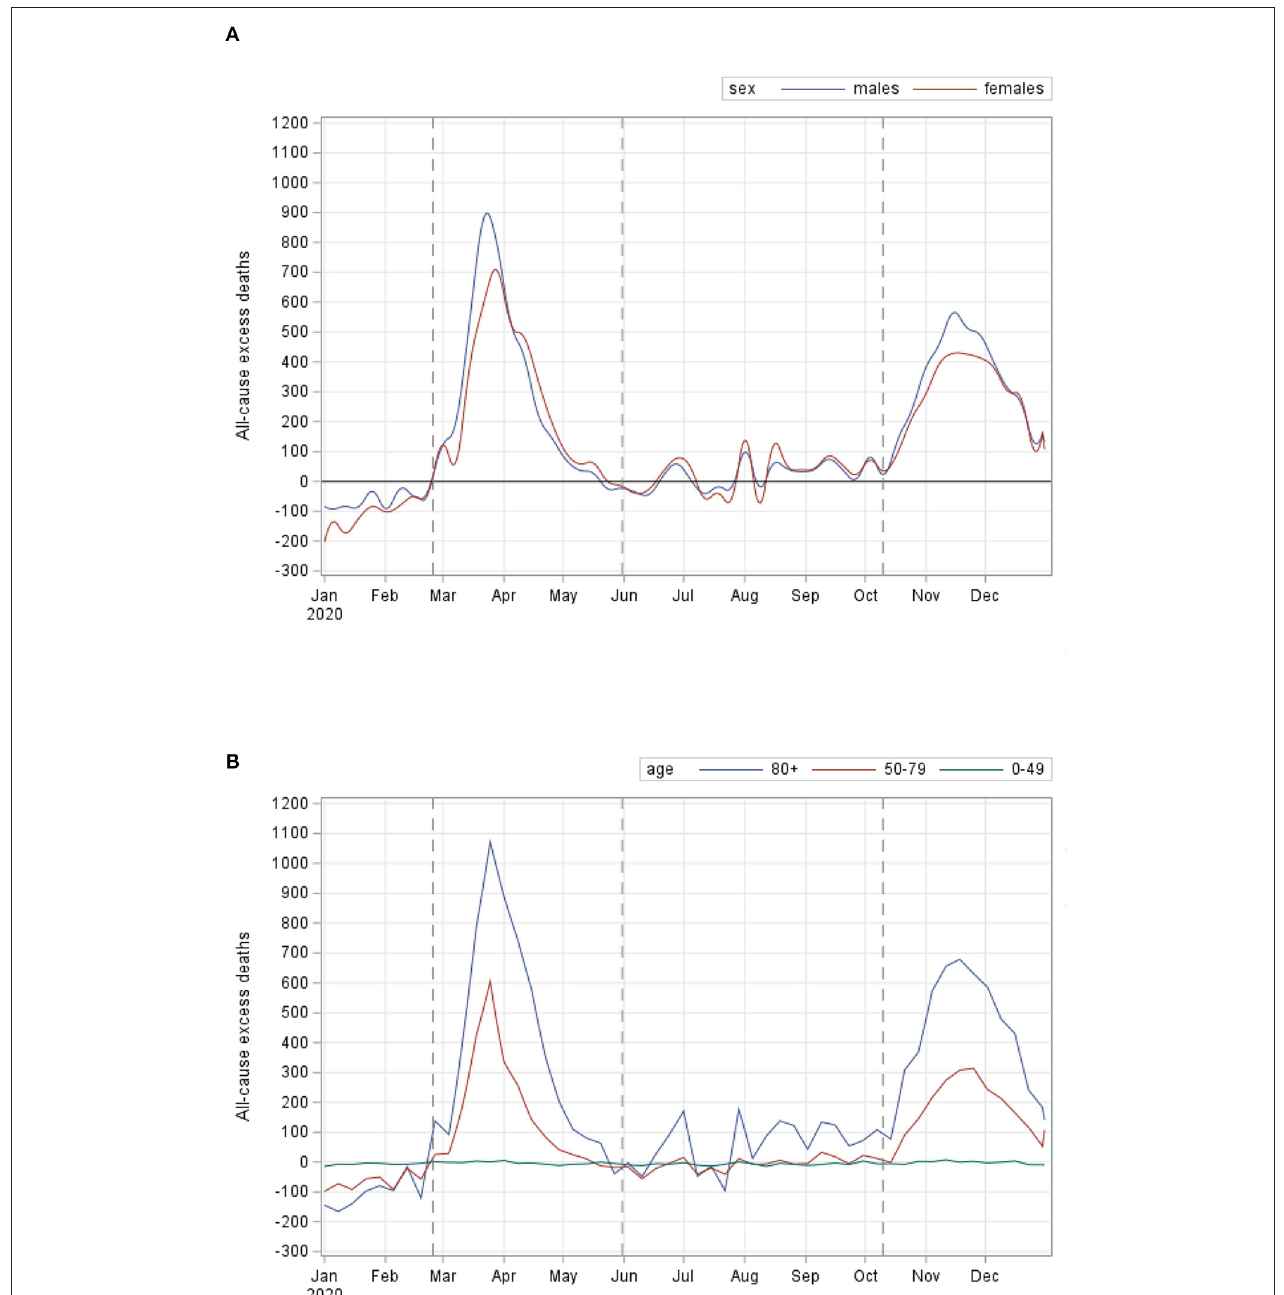
FIGURE 2 | All-cause excess deaths during the COVID-19 pandemic by sex (A) and by age groups (B) , Italy - year 2020.